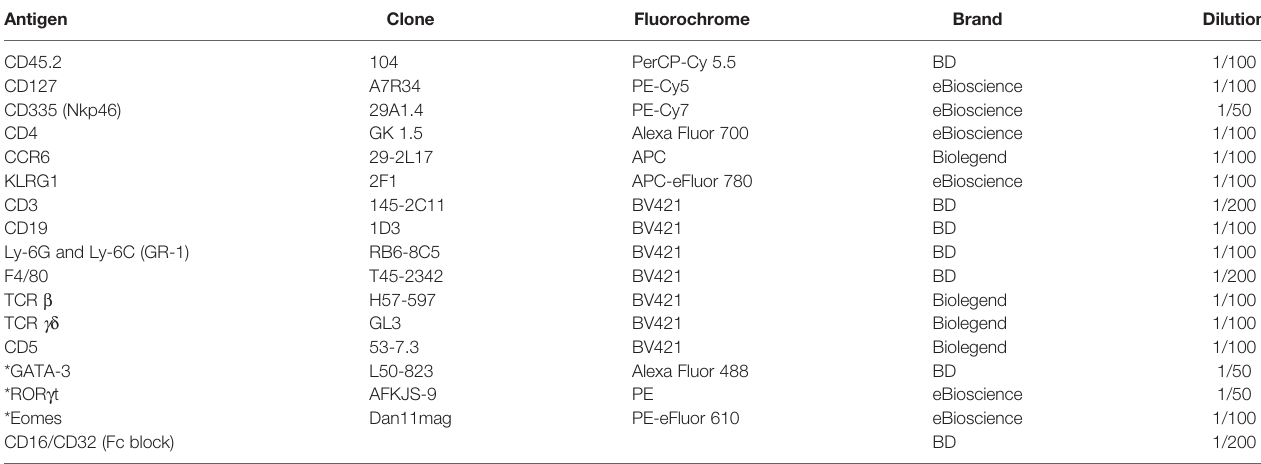
TABLE 2 | Protein markers for analysis of ILC populations by fl ow